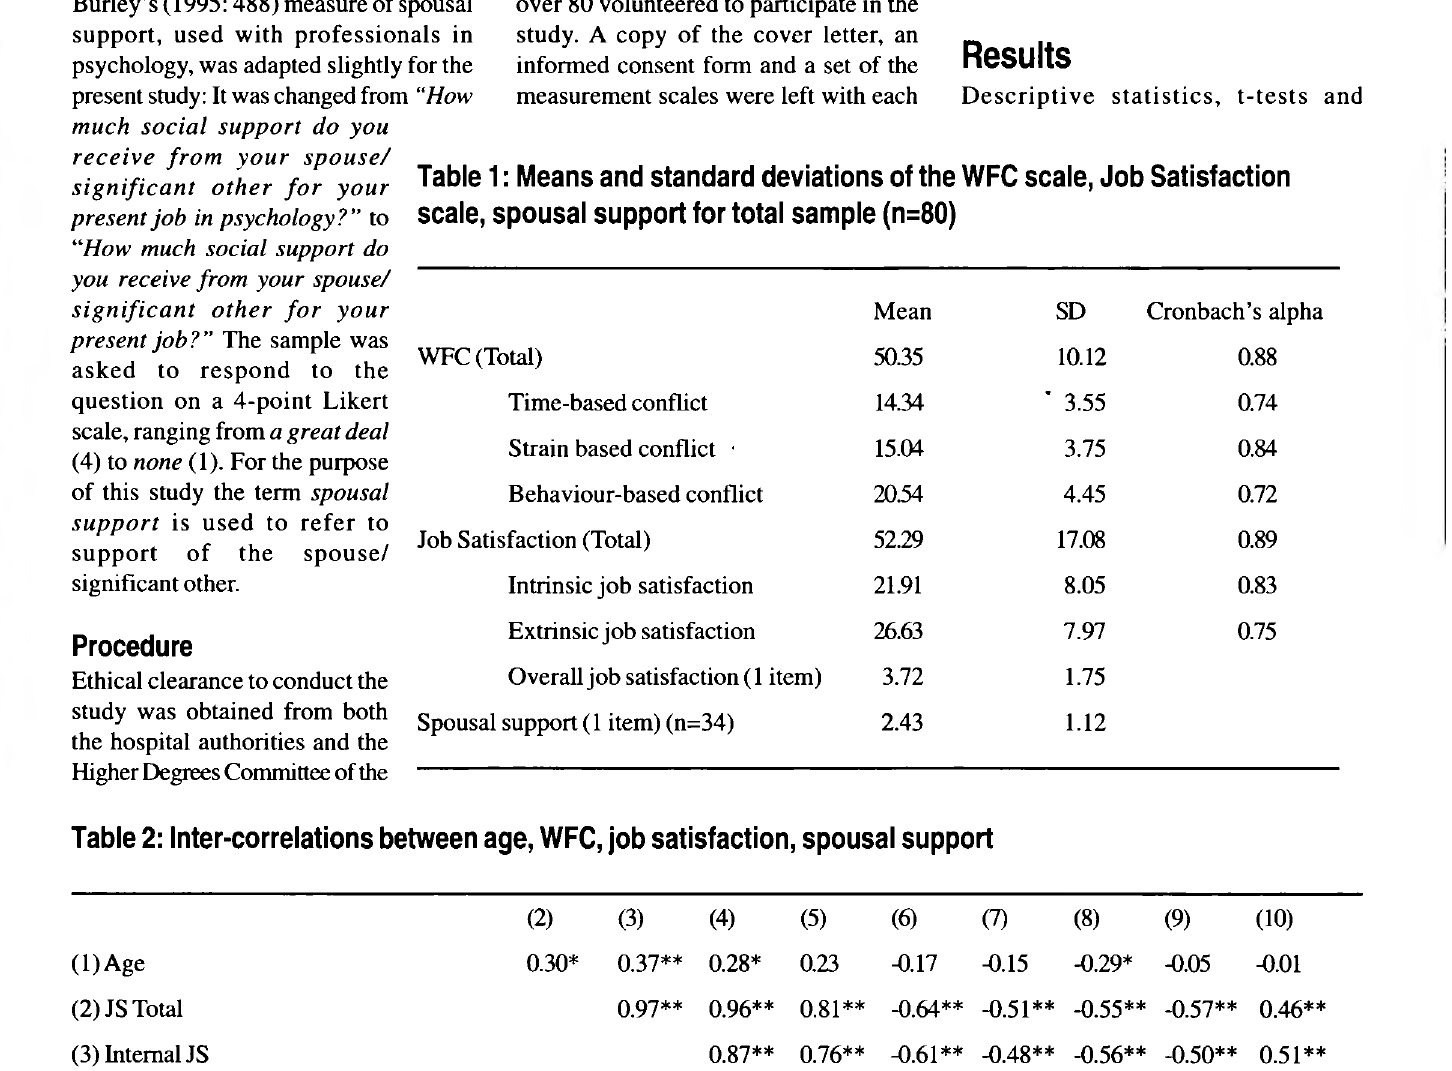
Table 1: Means and standard deviations of the WFC scale, Job Satisfaction scale, spousal support for total sample (n=80)